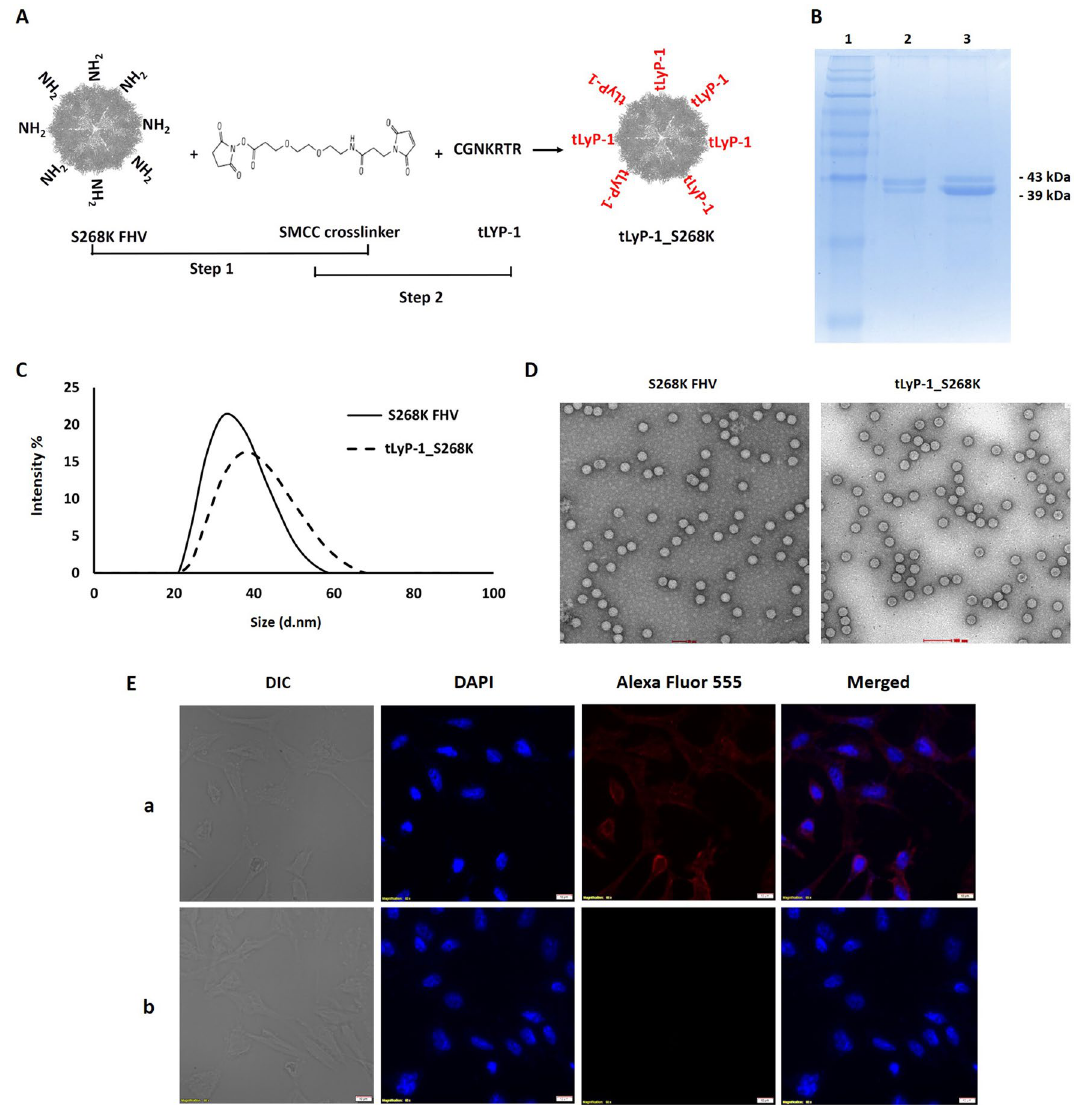
Figure 1. Conjugation of tumor homing peptide tLyP-1 to FHV VLPs ( A ) Schematic representation of tLyP-1 peptide attachment on the surface of S268K FHV VLP ( B ) SDS-PAGE of unconjugated and tLyP-1 conjugated S268K VLPs ( C ) Dynamic light scattering (DLS) of unconjugated and tLyP-1 conjugated S268K VLPs ( D ) Negative stain micrographs of unconjugated and tLyP-1 conjugated S268K VLPs at ×50,000 magnification; ( E ) Confocal microscopy showing binding of tLyP-1 conjugated (panel a) and unconjugated (panel b) S268K VLPs to MDA-MB-231 Encapsulation of drugs. For encapsulating drugs in the interior of the tLyP-1_S268K VLPs, the capsid structure was partially destabilized. It has been shown earlier that the FHV capsid incorporates Ca 2+ at the quasi 3-fold axis of symmetry and at subunit interfaces 26 . Removal of Ca 2+ by EGTA chelation destabilizes the capsid, which is evident from relatively lower melting temperatures, although the shell remains morphologically intact 32 . In order to facilitate the entry of drugs inside the capsid, tLyP-1_S268K VLPs were initially treated with 200 mM EDTA, followed by high molar excess of doxorubicin and ellipticine. After allowing sufficient time for packaging of drugs, tLyP-1_S268K VLPs were dialyzed against a buffer containing CaCl 2, for re-sealing of the particles. Particles were extensively dialyzed to remove any excess drugs, and the amounts encapsulated within the capsid shell were quantified using the intrinsic absorbance of doxorubicin and ellipticine. The absorbance of tLyP-1_S268K VLPs encapsulating doxorubicin (denoted Dox_tLyP-1_S268K) and ellipticine (denoted EPT_ tLyP-1_S268K) were measured at 495 nm and 310 nm respectively. The amount of doxorubicin and ellipticine present in a particle population was quantified from standard curves of the drugs (Fig. 2A,B). tLyP-1_S268K VLPs, in contrast to Dox_tLyP-1_S268K and EPT_tLyP-1_S268K, did not display any quantifiable absorbance at 495 or 310 nm. In order to generate a drug molecule/particle ratio, the capsid protein in the same particle population was quantified by densitometric analysis of denatured VLPs resolved on a 15% SDS-PAGE (Fig. 2C). Our quantification studies suggest encapsulation of ~ 130,000